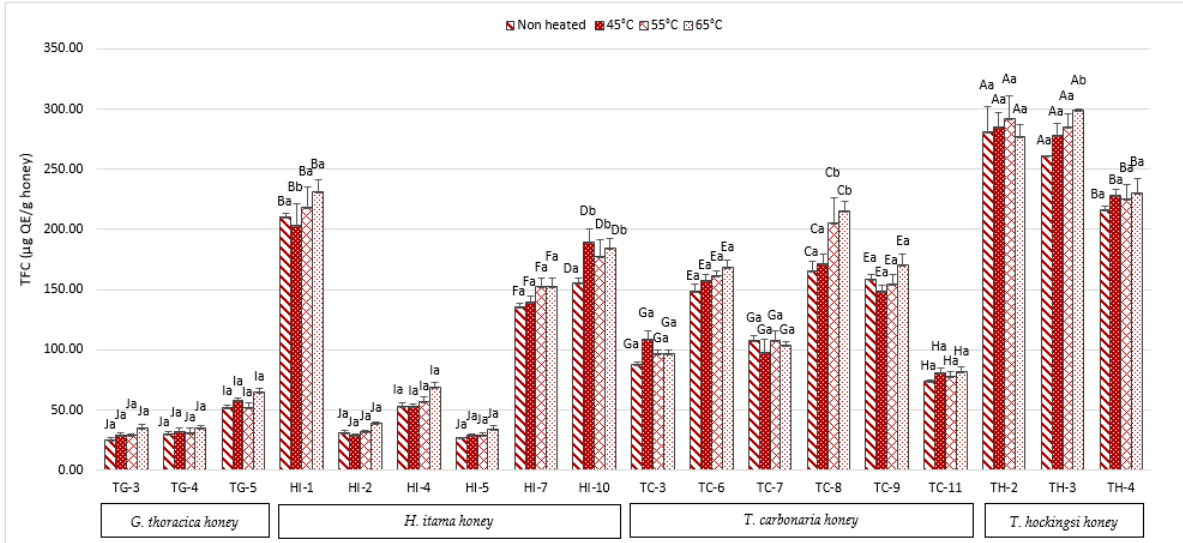
Figure 2. Total flavonoid content of Malaysian and Australian stingless bee honey. Different superscripts, a and b, indicate significant differences ( p < 0.05) between the temperatures, and different superscripts, A – J, indicate significant differences ( p < 0.05) between the stingless bee honeys.